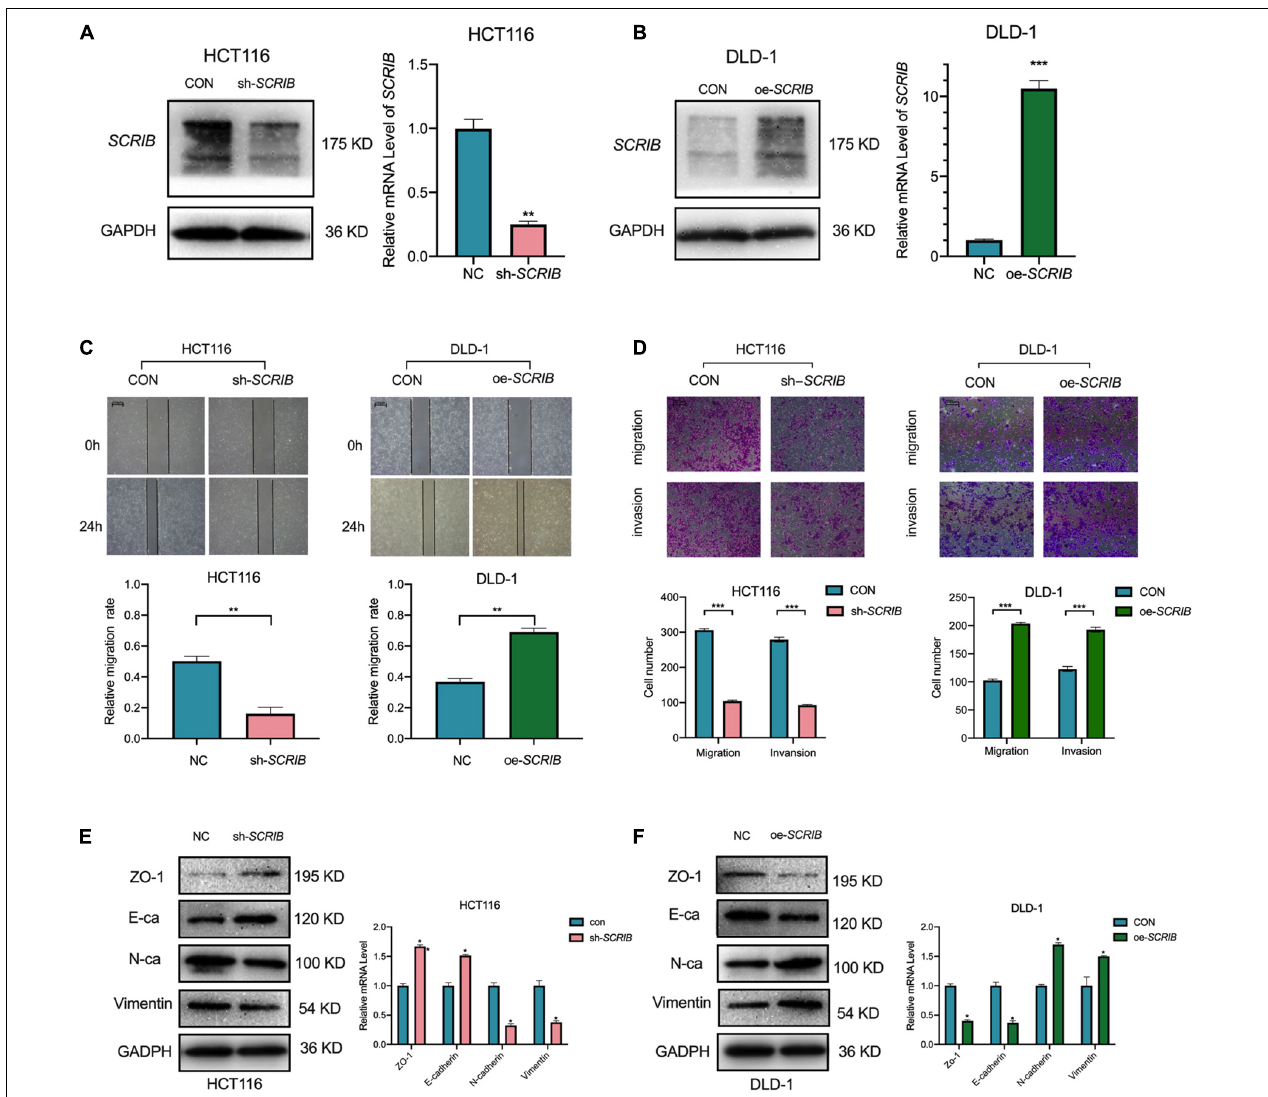
FIGURE 2 | SCRIB promotes the migration and invasion of CRC cells in vitro . SCRIB was knocked down and overexpressed in HCT116 and DLD-1 cells, respectively. The efficiency of knockdown and overexpression was verified by qRT-PCR and WB (A,B) . (C) Effects of SCRIB on migration in CRC cell lines were detected by wound healing assay, scale bars: 100 µ m. (D) Cell migration and invasion of HCT116 and DLD-1 cells as measured by Transwell assays; scale bars: 100 µ m. (E) Western blot analysis of the tight junction protein ZO-1, epithelial marker E-cadherin, and mesenchymal markers N-cadherin and Vimentin after SCRIB knockdown in HCT116 cells. (F) The same molecules were observed in DLD-1 cells overexpressing SCRIB . The data represent the mean ± SD from three independent experiments. Student’s t -test was used to determine statistical significance: * P < 0.05, ** P < 0.01, and *** P <